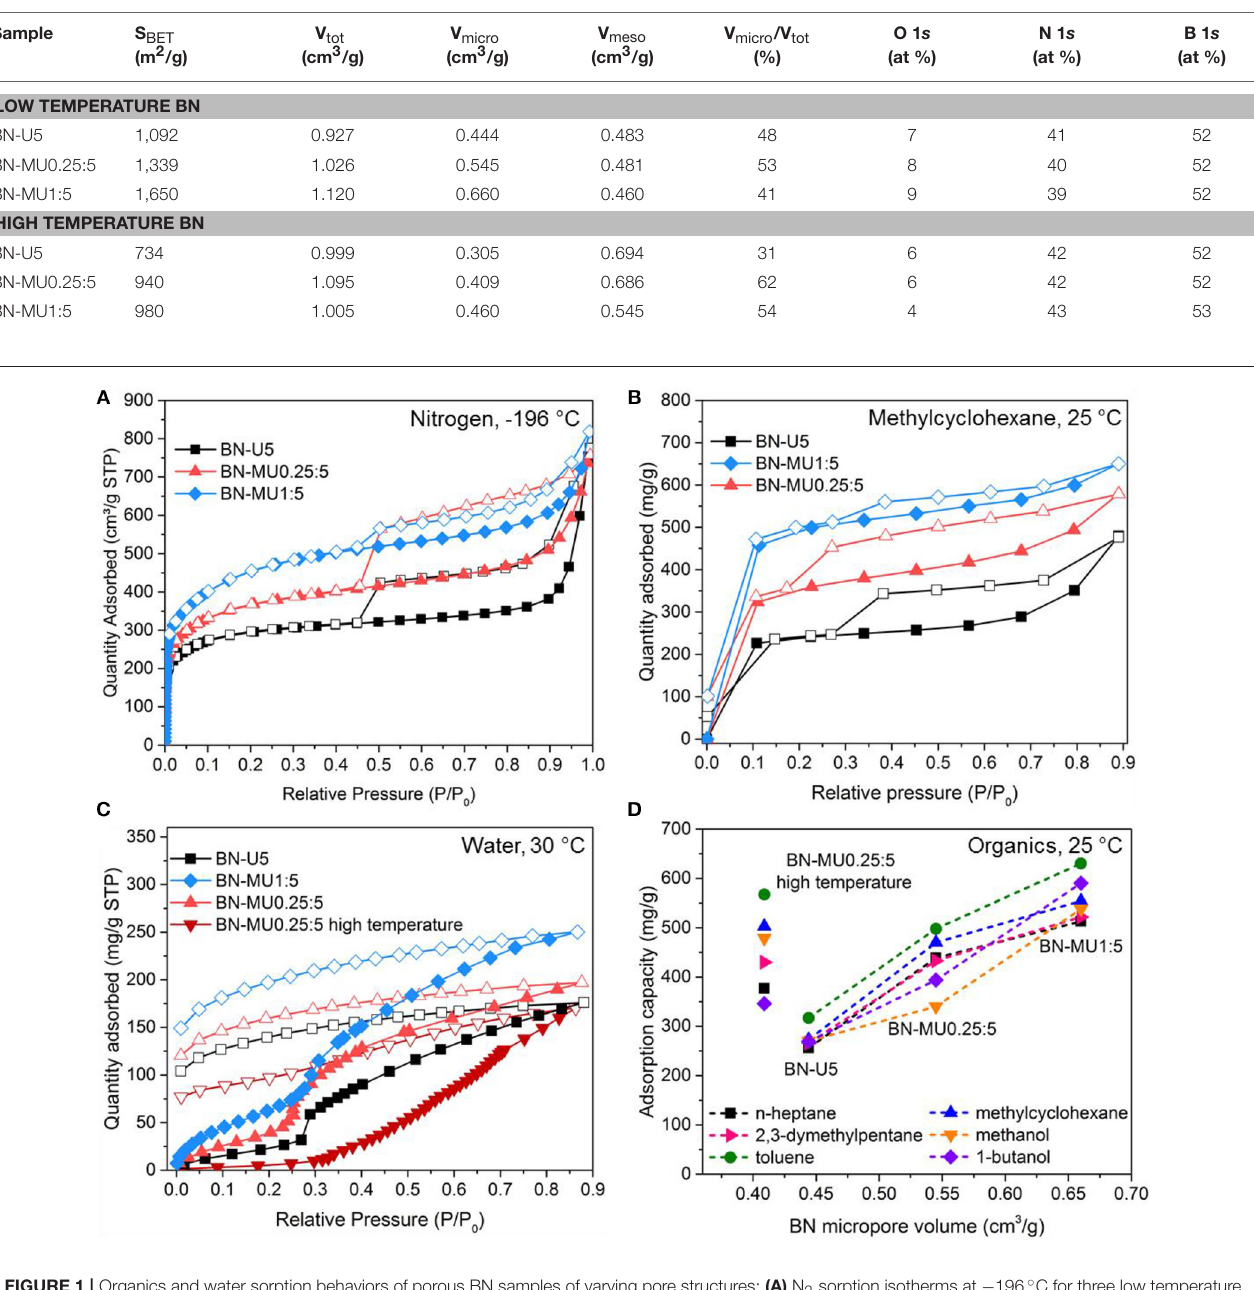
dictated by the pore structure of the materials. In fact, the organic vapor sorption isotherms followed the same patterns as the nitrogen sorption at − 196 ◦ C (compare Figures 1A , B ). The total vapor sorption capacity increased with increasing surface areas and most of the vapors were adsorbed at low relative